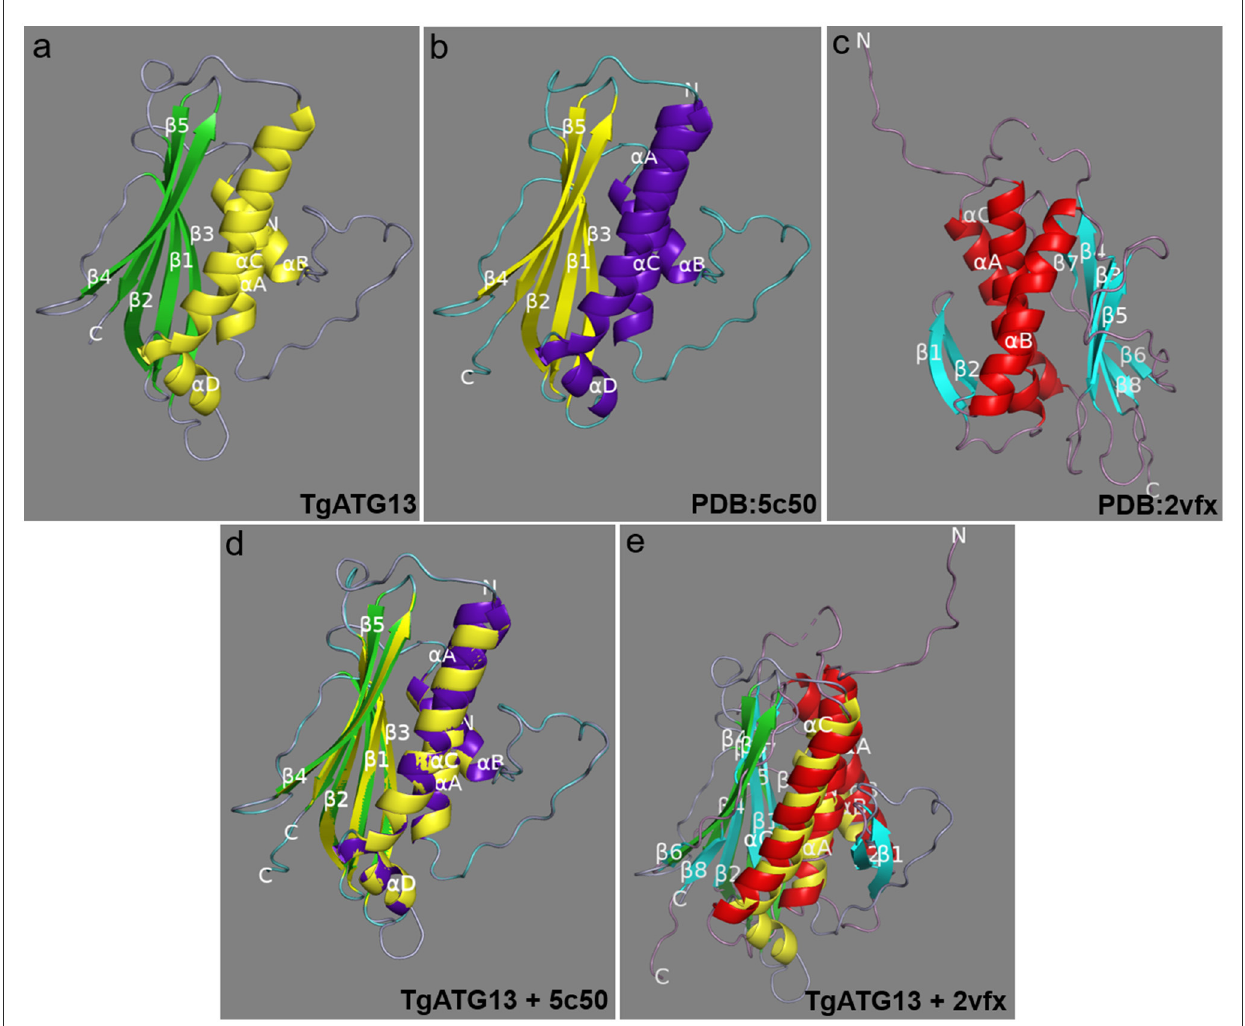
FIGURE4 Molecular structure of the TgATG13 HORMA domain. (a) Predicted structural model of the N-terminal HORMA domain of TgATG13. (b) Reference model human ATG101-ATG13 complex HORMA domain (PDB ID: 5C50). (c) Spindle checkpoint protein Mad2 dimer (PDB ID: 2VFX). (d) The 3D image of the N-terminal HORMA domain of TgATG13 was superimposed on the reference model ATG13 (PDB ID: 5C50). (e) The 3D image of the N-terminal HORMA domain of TgATG13 was superimposed on the Mad2 dimer (PDB ID: 2VFX). The α -helix and β -sheet of the reference model are expressed in purple and yellow, respectively. The α -helix and β -sheet of the TgATG13 HORMA domain model are expressed in yellow and green. The α -helix and β -sheet of the Mad2 dimer model are expressed in red and light